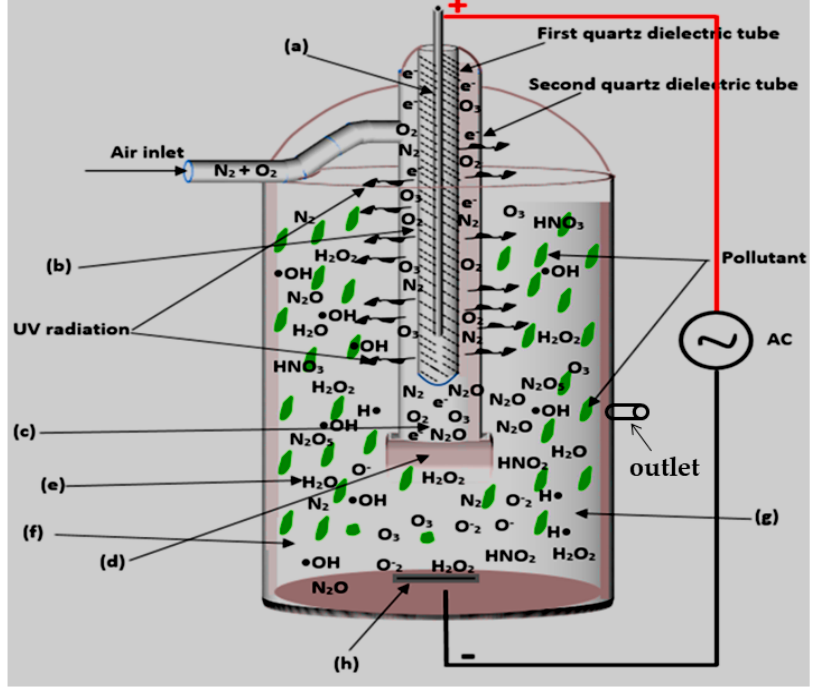
Figure 14. Different reaction zones encountered in the dielectric barrier discharge (DBD) system [120].